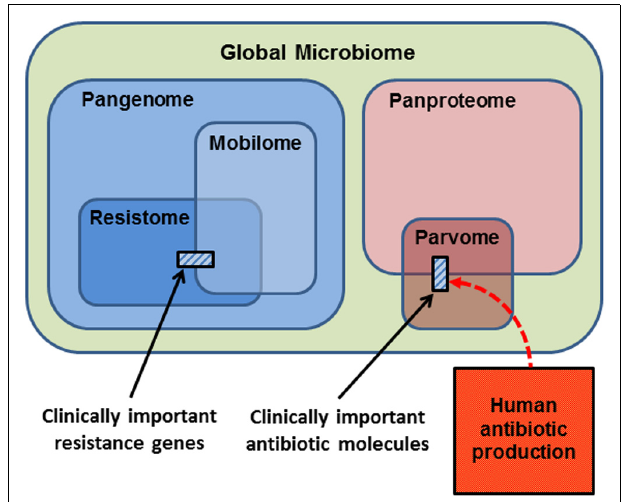
FIGURE 2 | Conceptual representation of the biological molecules of relevance to antibiotic resistance. The small cross-hatched boxes represent the antibiotics and resistance genes of relevance to clinical practice. Respectively, these are a small subset of the world of small bioactive molecules (the parvome), and the world of potential resistance determinants (the resistome).The resistome comprises the genes that potentially encode resistance to antibiotics.The mobilome comprises the mobile proportion of bacterial genomes.The mobilome and resistome overlap, since many resistance genes are located on mobile elements. Both the resistome and mobilome are a subset of the total coding capacity of prokaryotic cells, the pangenome, which is expressed as the panproteome. Note that only a small proportion of the parvome is utilized by humans for antibiotic purposes, and that the scale of commercial antibiotic production probably overwhelms the natural production of these molecules by the entire global